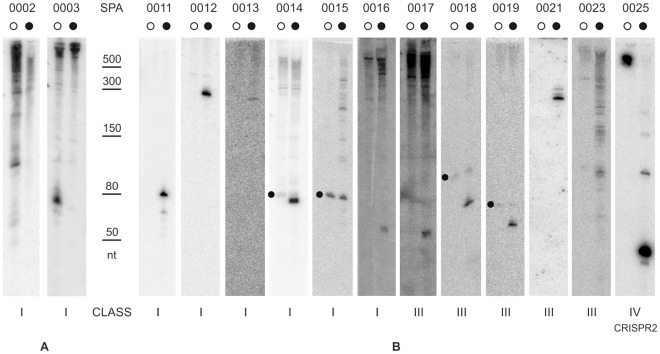
Validation of candidate sRNAs expressed from unique nstSGR in either PAO1 or PA14.A selection of nstSGRs listed in Table S2, unique in either PAO1 or PA14, were inspected by Northern blot for the expression of sRNAs. Total RNA was extracted from both PAO1 (○) and PA14 (•) grown in the same conditions as for sRNA-Seq. Equal amounts of RNA (8 µg) from both strains were blotted and probed with radiolabelled riboprobes (0002 and 0021) or oligos (Table S1) complementary to nstSGR regions with the highest read coverage, as detailed in Materials and Methods. Validated unique sRNAs in PAO1 or PA14 are shown in (A) and (B), respectively. For SPA0014, 0015, 0018, 0019, signals detected in both strains (dots on the left of PAO1 lanes) can be due to aspecific probe hybridization. The ladder of molecular weight markers is shared by (A) and (B). (nt): nucleotides.